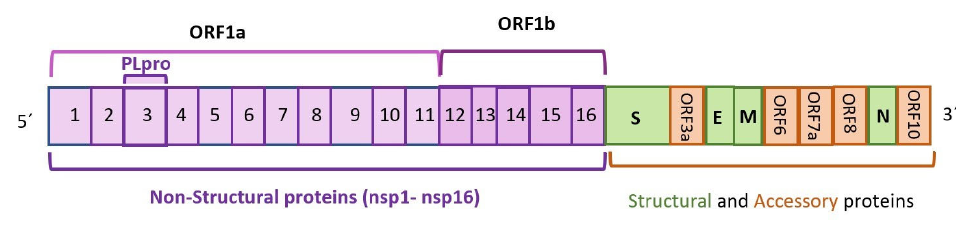
Figure 1. Genome of SARS-CoV-2 virus showing ORF1a and ORF1b open reading frames. Autophagy plays an essential role in promoting RNA virus replication by inhibiting innate antivirus immune responses [12], or promoting infectivity via the autophagy-related secretion of vesicles loaded with virus